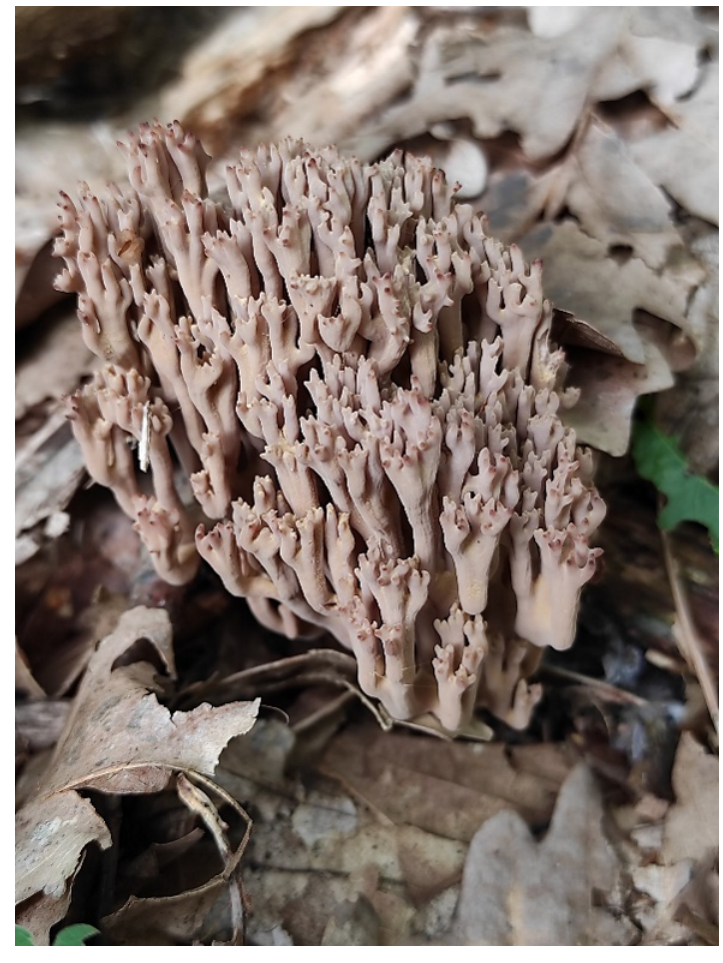
Figure 7 Basidiomata of Ramaria fennica var. fumigata from Kampinos National Park; September 4, 2021. Photography by A.